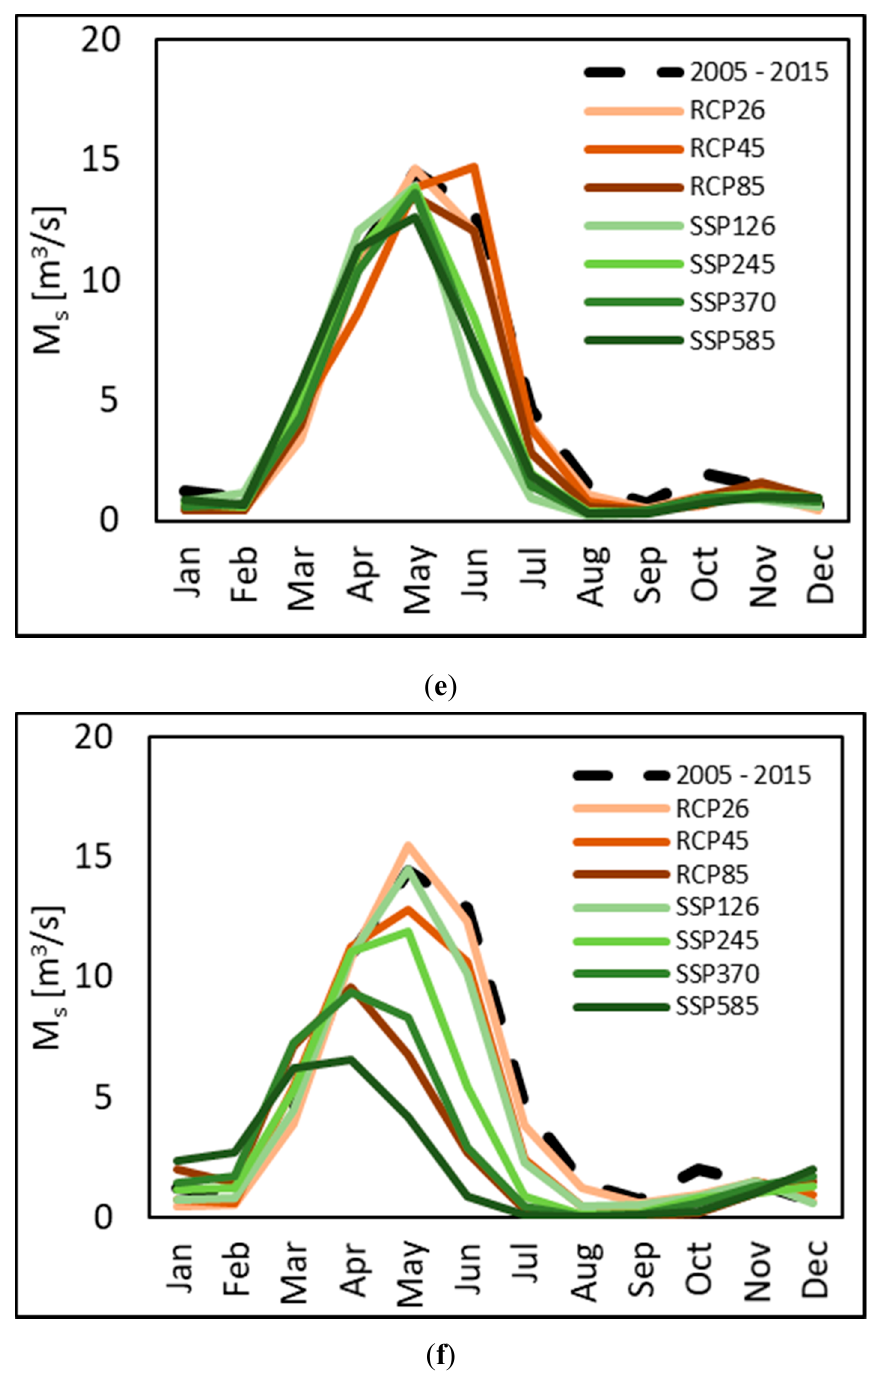
Figure 5. Projected mean monthly values of energy production E (GWh), discharge Q (m 3 s − 1 ) and snow melt M s (m 3 s − 1 ). Each line displays the value for a given RCP / SSP, averaged for all GCMs (CMIP5 / CMIP6). ( a ) E period P1. ( b ) E period P2. ( c ) Q period P1. ( d ) Q period P2. ( e ) M s period P1. ( f ) M s period P2.